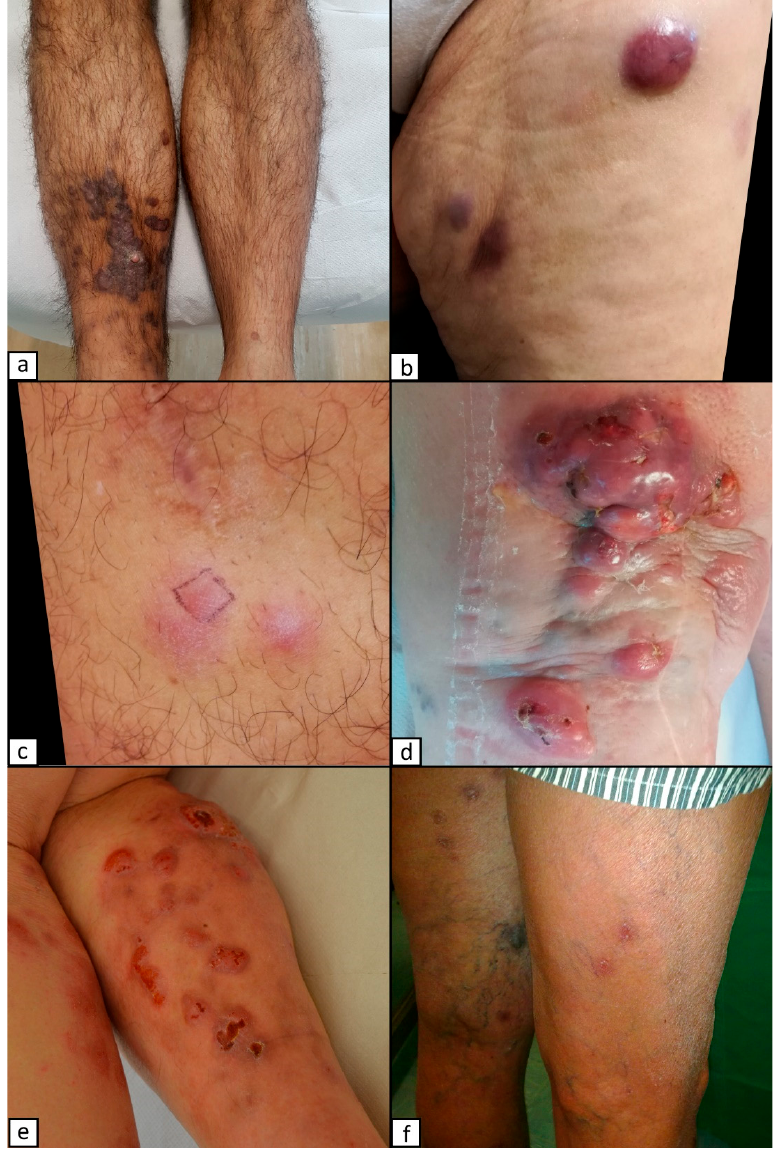
Figure 1. Erythematous to purplish nodules and plaques located on the leg in different diseases, ( a ) a purplish plaque and nodules along with monoliteral edema of the leg in a Kaposi sarcoma case, ( b ) purplish nodules in a primary cutaneous marginal zone lymphoma, ( c ) erythematous subcutaneous nodules in a primary cutaneous follicle center lymphoma; ( d ) multiple nodules along with crusty lesions in a primary cutaneous diffuse large cell lymphoma; ( e ) multiple ulcerated nodules and erythematous plaques in a mycosis fungoides; ( f ) erythematous nodules on the legs in a blastic plasmacytoid dendritic cell neoplasia case. In immunohistochemistry, staining against HHV-8 results in positive staining in spindle cells. Scheduled treatments depend on the clinical variant, KS extension and immune system status. Dermoscopy of KS can be helpful, and polychromatic color change (Rainbow pattern), collarette sign, white lines, white clouds, and serpentine vessels have